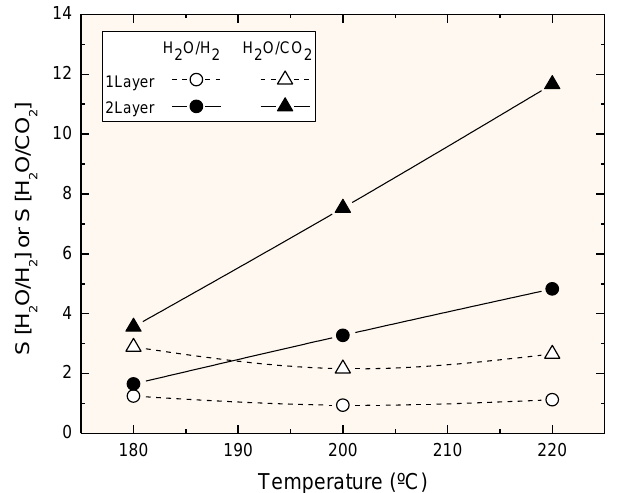
Figure 4. Selectivity (H 2 O/H 2 or H 2 O/CO 2 ) for the two membranes as a function of temperature.